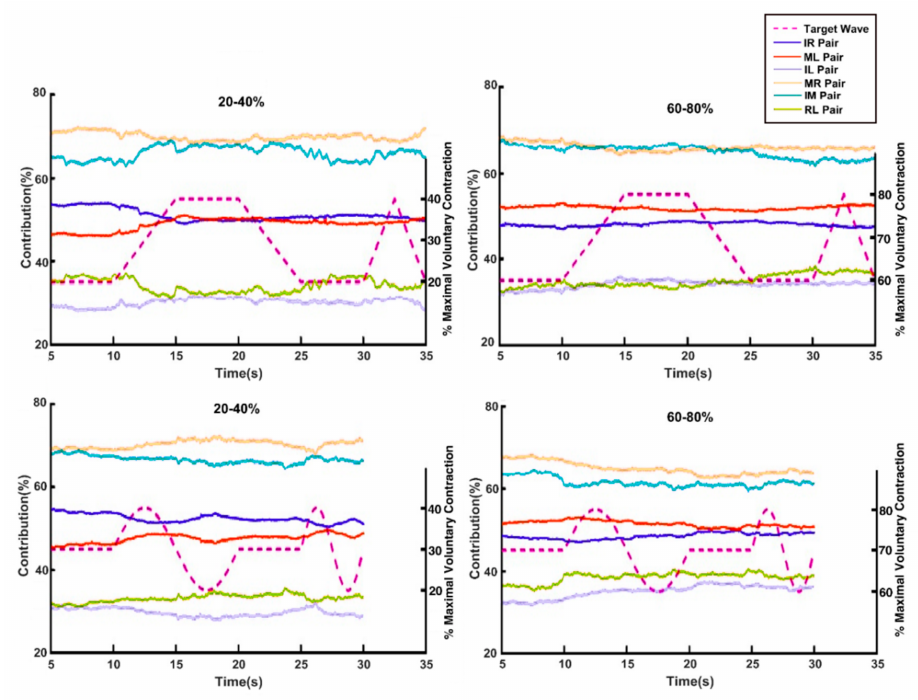
Figure 4. Force-contribution curves of grouped fingers. Values of force contribution refer to the left vertical axis and values of target wave refer to the right vertical